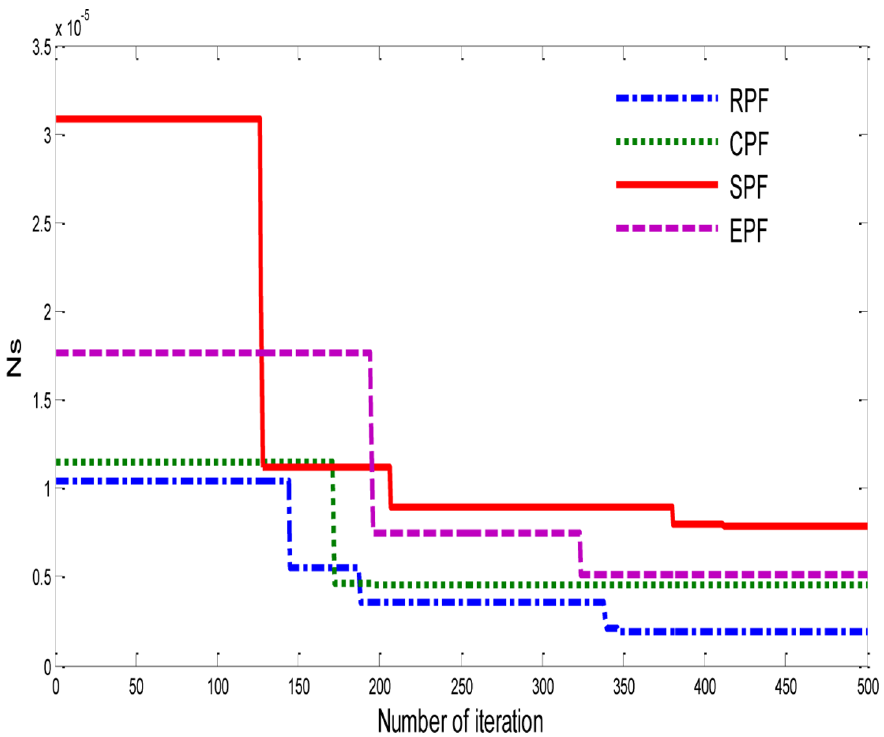
Figure 7. Effect of pin fin shape on dimensionless total entropy generation rate ( Ns ) for P=6, e ~ 0 : 5 , and Re ‘ ~ 300 .